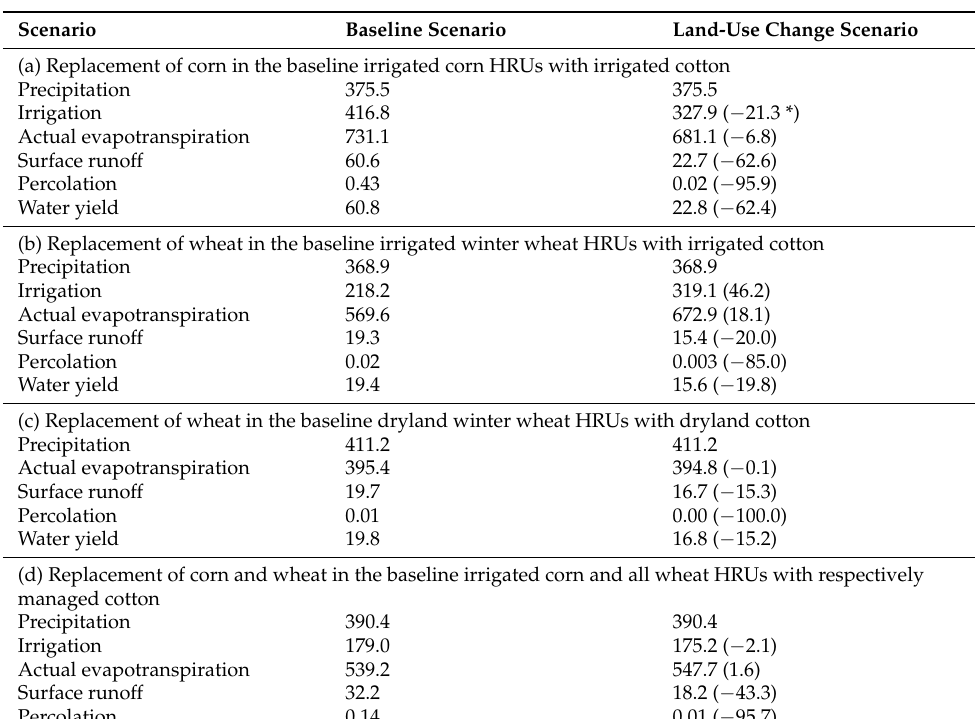
Table 4. Comparison of the average (2000–2014) annual water balance parameters (mm) under baseline and land-use change scenarios in the corn and winter wheat HRUs in the Palo Duro watershed.